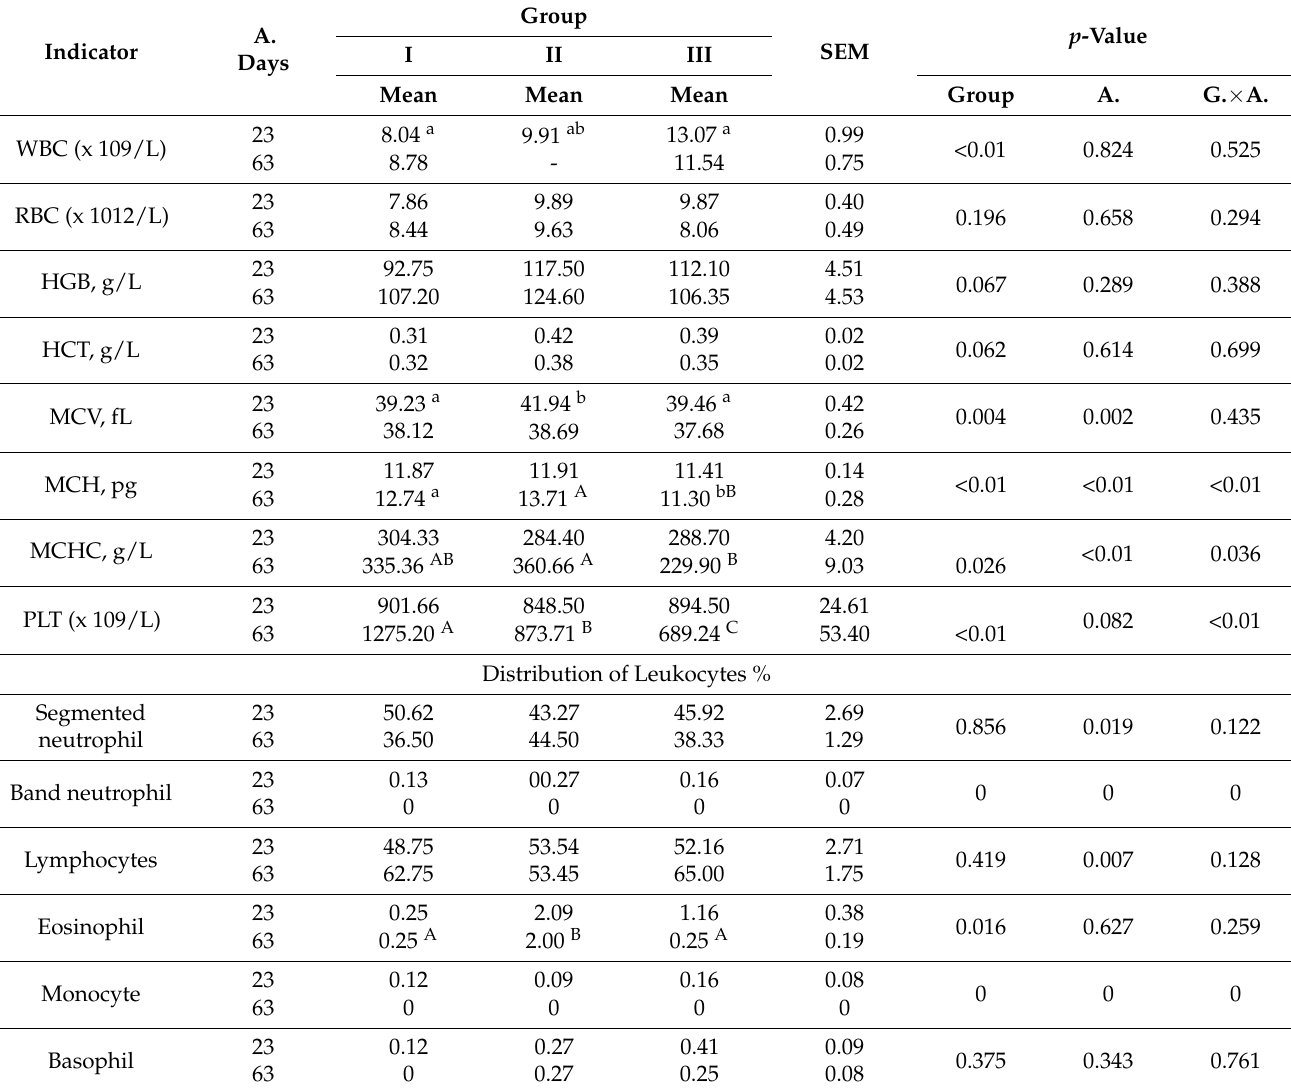
Table 5. Blood hematological indicators in